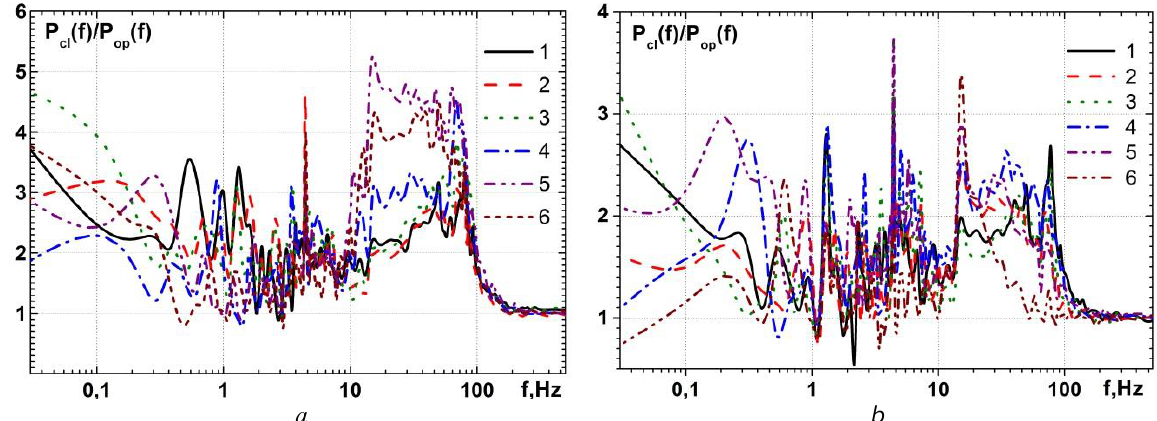
Figure 10. Ratios of the power spectral densities of the pressure fluctuations through the semi-closed valve to the open valve near the side jet (a) and near the central jet